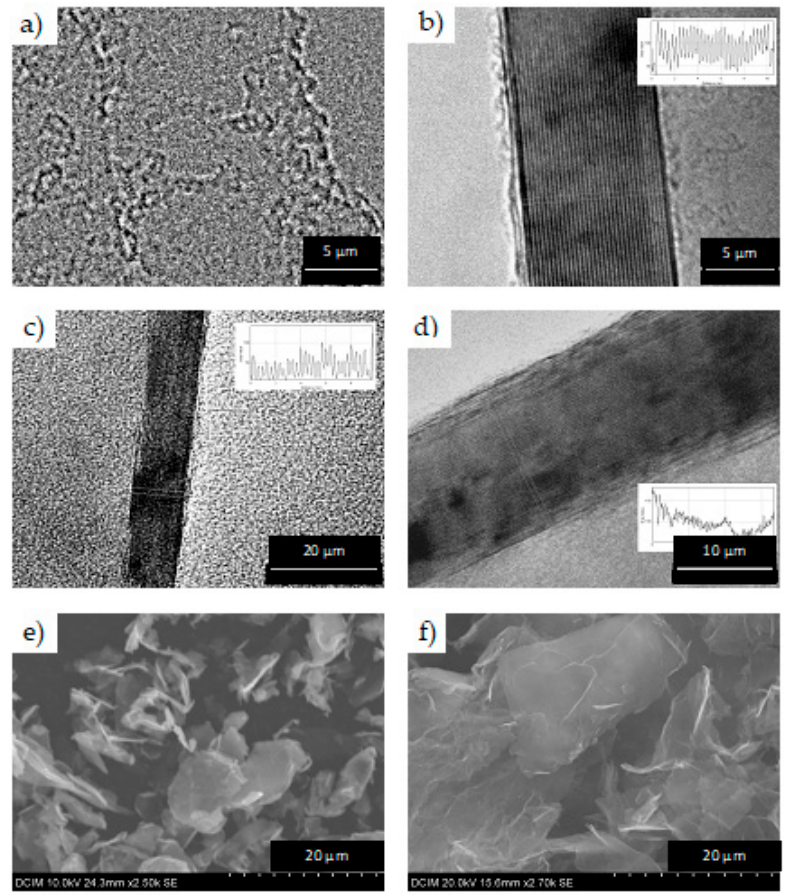
Figure 1. TEM micrographs of ( a ) GNP1; ( b ) GNP2; ( c ) GNP3; ( d ) GNP4 and SEM micrographs of ( e ) GNP2 and ( f ) GNP4.